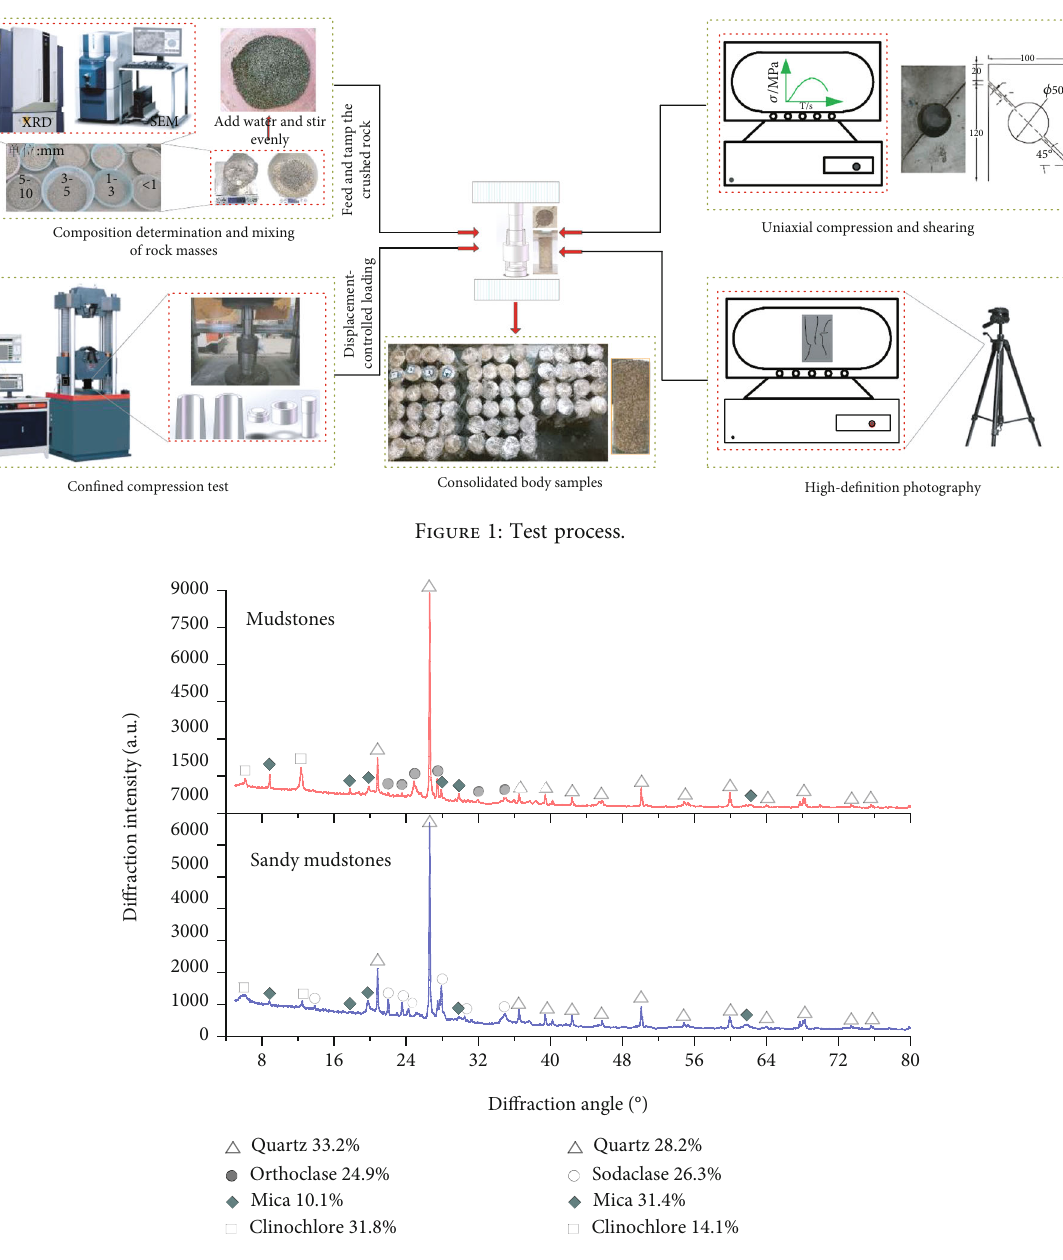
Figure 2: XRD spectra of crushed rock